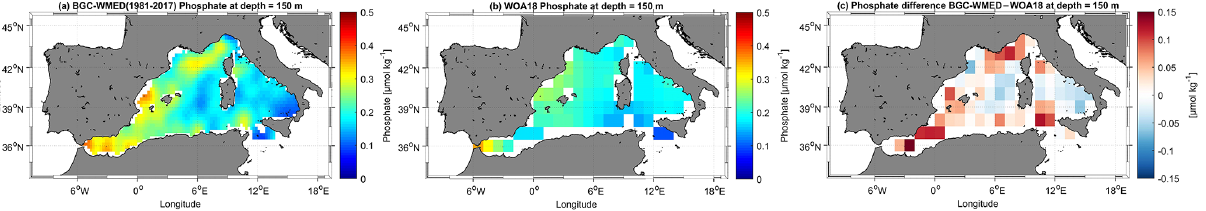
Figure 12. The same as Fig. 11 but for